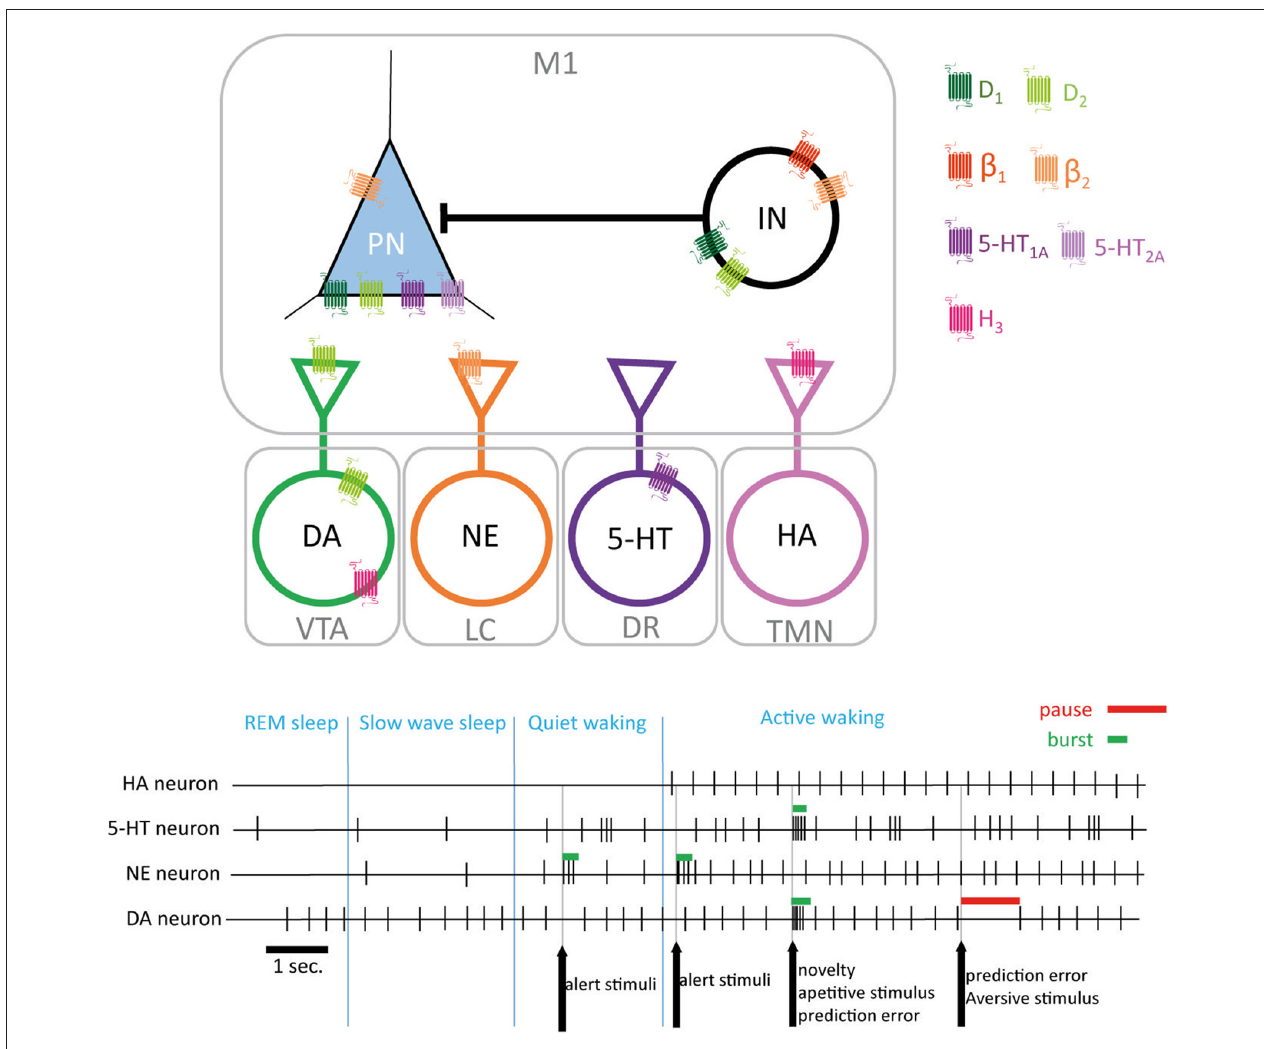
FIGURE 6 | Monoaminergic modulation of M1. Monoamines projecting to M1 interact at pre and post synaptic levels both on pyramidal neurons (PN) and interneurons (IN). Extracellular levels of monoamines are related to sleep/wake states (encoded by tonic firing frequency in HA, 5-HT and NE neurons) and to environmental stimuli supporting attentional/alert information (encoded by bursts or pause in the firing activity by 5-HT, E and DA neurons). DA, dopamine; NE, norepinephrine; 5-HT, serotonin; HA, histamine; M1, primary motor cortex; VTA, ventral tegmental area; LC, locus coeruleus; DR, dorsal raphe; TMN, tuberomamillary